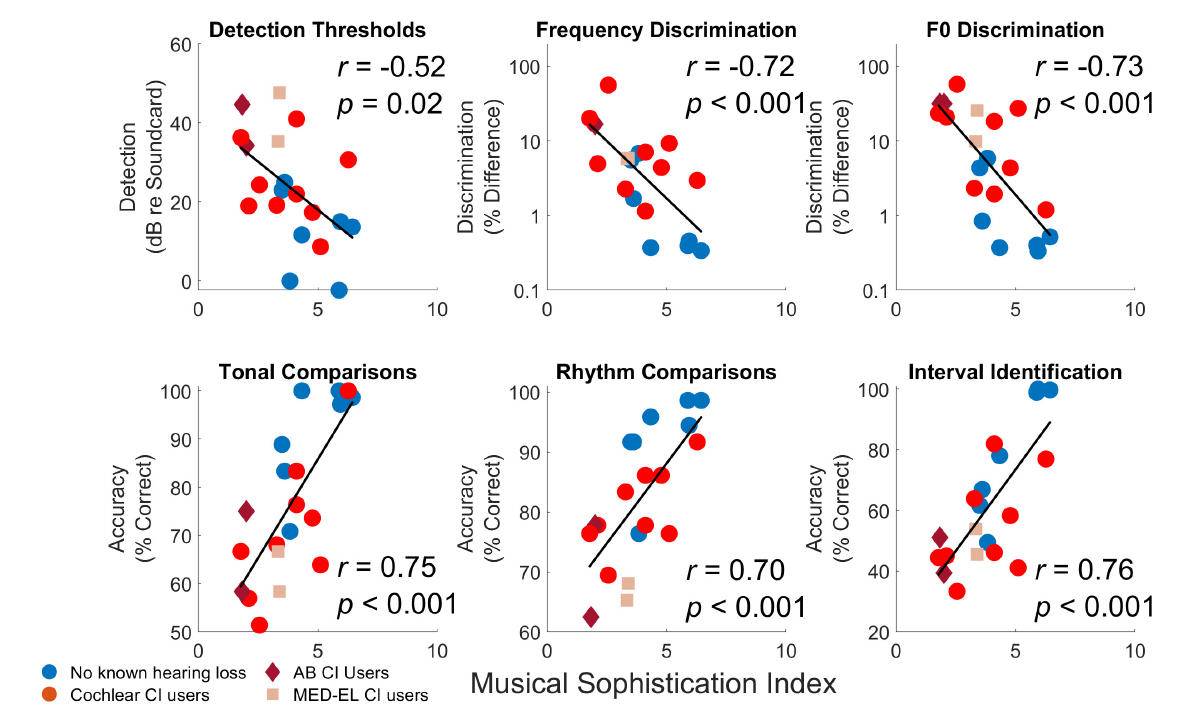
FIGURE8 Comparisons of Musical Sophistication Index (MSI) with individual results from different procedures based on averages across conditions. For each comparison, each symbols represents the average measure for each individual participant averaged across conditions and repetitions. Individual thresholds for cochlear implant users with implants from Cochlear Corporation are represented with a circle (red), Advanced Bionics with a diamond (dark red), and MED-EL with a square (light red).